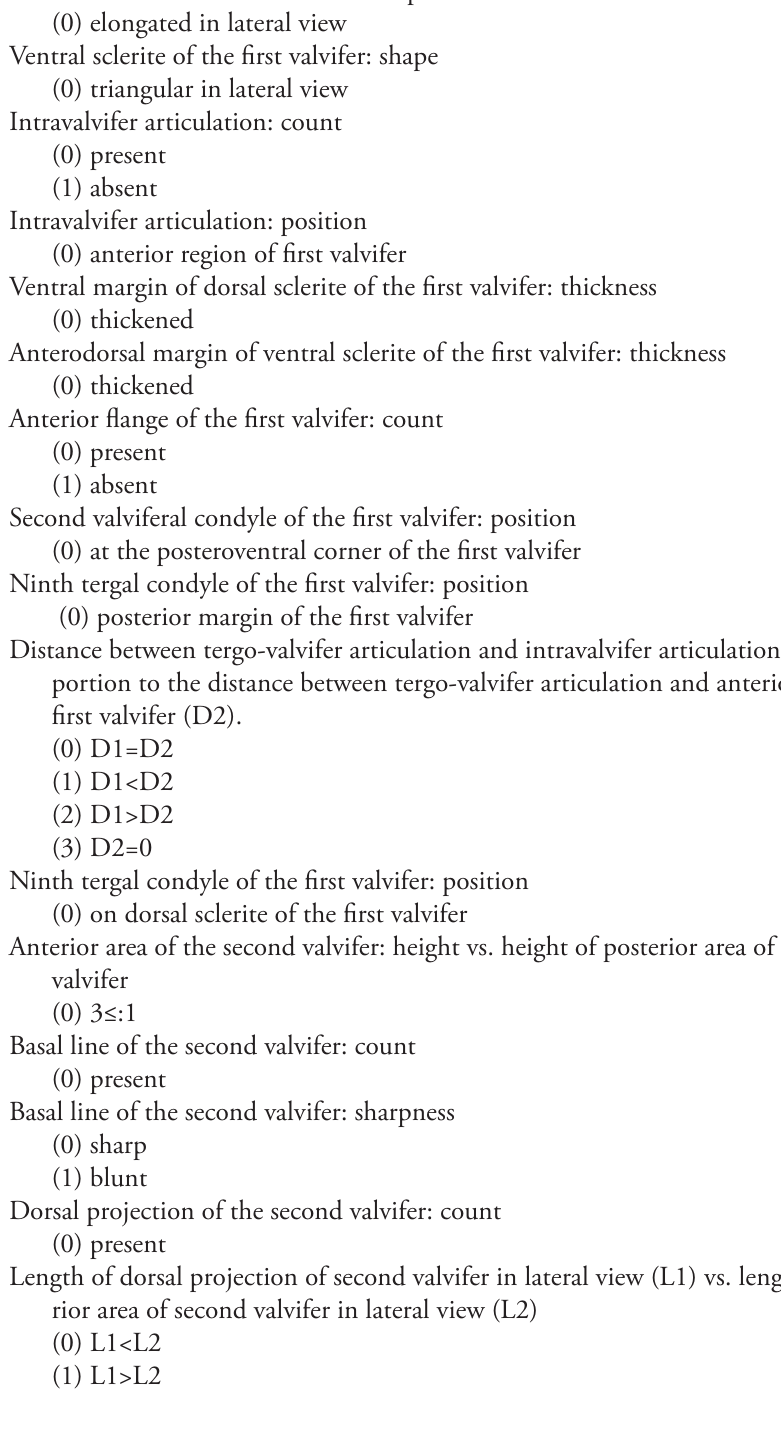
Dorsal sclerite of the first valvifer: